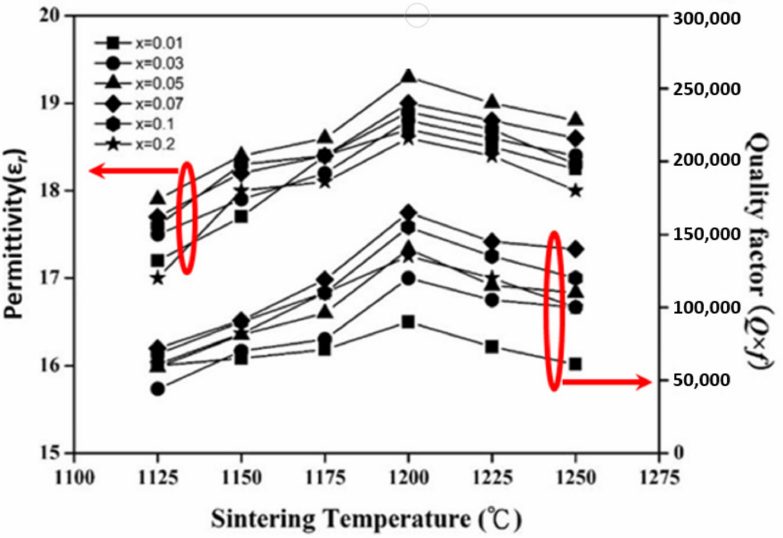
Figure 6. Permittivity and quality factor of the (Mg 0.6 Zn 0.4 ) 1 − y Ni y TiO 3 with y = 0.01–0.2 under 1125–1250 ◦